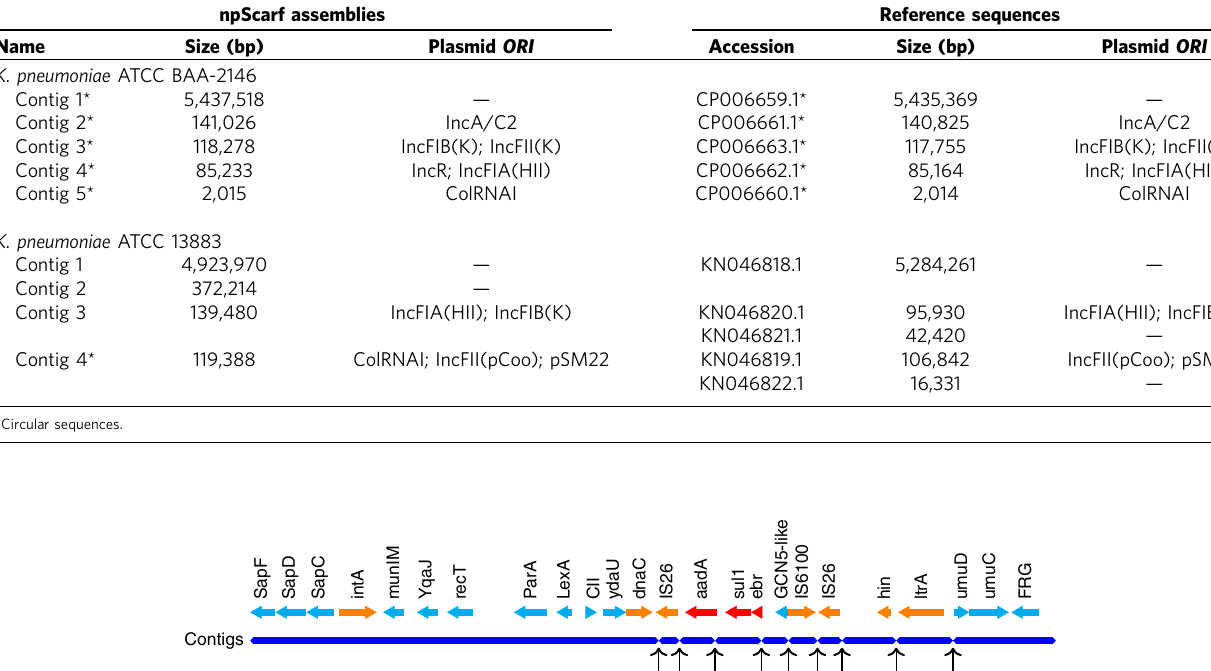
Table 1 | Comparison between npScarf’s assemblies and the reference genomes of two K. pneumoniae strains.